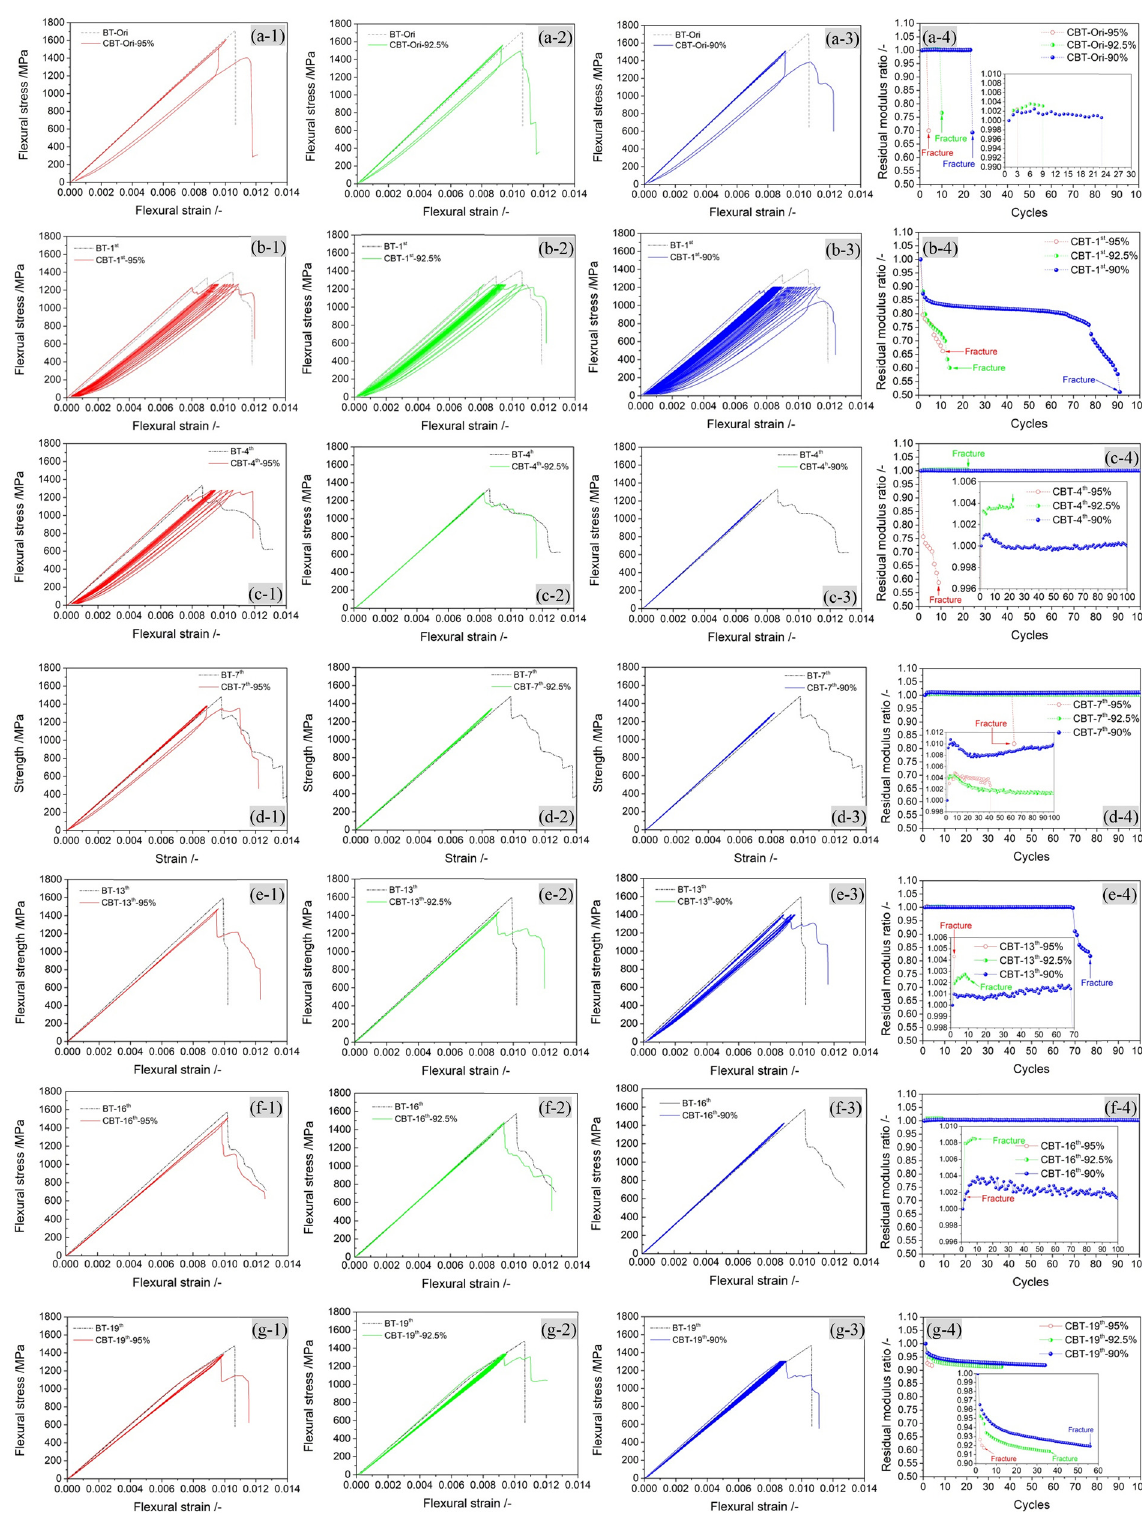
Figure 8: Typical cyclic flexural stress – strain curves of CF/epoxy laminates with and without fiber breakage in different layers: ( a ) original,